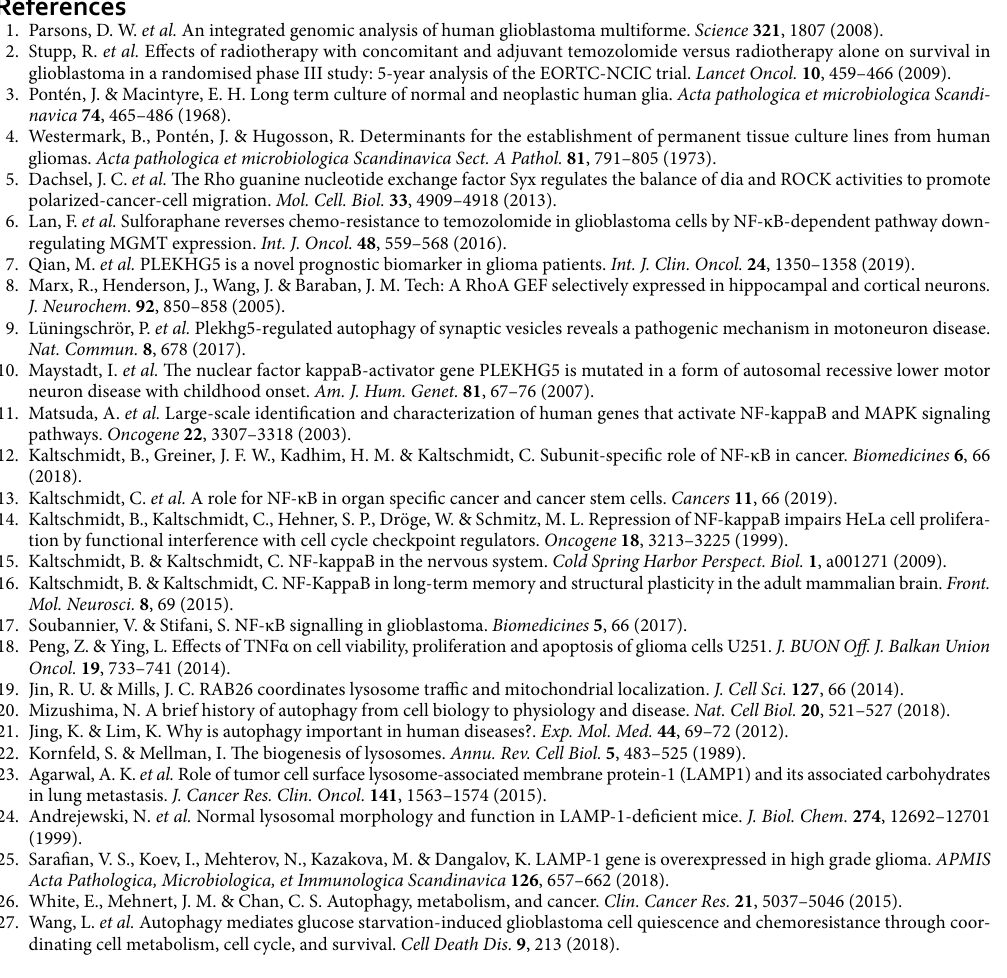
Figure 8. PLEKHG5 regulates NF-κB and MGMT in U251-MG. ( A ) Immunocytochemistry showed strong accumulations on MGMT expression after transduction with RAB26QL. Overexpression of RAB26 seemed to correlate with the amounts of MGMT protein, whereas PLEKHG5 rescue cells represented high levels of MGMT. ( B ) Survival analysis were performed by using Orangu Cell Proliferation Assay via measurement of photometric absorbance at 450 nm (upper row) and via determination of resulting cellular viability (lower row), after treatment with TMZ. Viability percentages of PLEKHG5 knockout and transduced U251-MG cells were examined compared to wildtype viabilities for each condition. PLEKHG5 +/+ cells showed significant decreases of OD’s/viabilities from control to treated cells. PLEKHG5-deficient cells depicted in all conditions very low levels of metabolic activity/cellular viabilities, compared to PLEKHG5 wildtype. Overexpression of RAB26 in PLEKHG5 −/− + RAB26QL cells recovered the sensitivity to TMZ, similarly to PLEKHG5 wildtype and rescued the cellular viability completely as compared to PLEKHG5 +/+ cells. PLEKHG5 +/+ + RAB26QL cells showed slightly lower levels of cellular viabilities but a similar trend as PLEKHG5 wildtype. Statistical analysis were performed with Mann–Whitney U tests (eight analysis for each condition and cell line), *** p ≤ 0.001, ** p ≤ 0.01 and * p ≤ 0.05 were considered significant. Mean ± SEM. ( C ) MGMT promoter methylation status of U251-MG and technical controls were analysed via bisulfide sequencing, depicting an average of 74.9 ± 5.3% methylated CpG-islands in PLEKHG5 wildtype, compared to PLEKHG5 knockout with 44.3 ± 4.8% of promoter methylation. Constitutive activity of RAB26QL in U251-MG cells displayed an intermediate phenotype with a promoter methylation average of 59.6 ± 4.0% ( PLEKHG5 rescue) and 72.9 ± 4.4% ( PLEKHG5 +/+ + RAB26QL). No statistical difference was examined between PLEKHG5 +/+ and PLEKHG5 +/+ + RAB26QL. One-way ANOVA with Bonferroni’s multiple comparison test, *** p ≤ 0.001 (grouped for each cell line and CpG-islands) was considered significant. Mean ± SEM. ( D ) Schematic representation of the analysed relation from PLEKHG5 to its downstream targets (black arrows). Next to regulating MGMT expression and cell morphology, PLEKHG5 was revealed to modulate cellular viability, which is directly associated with U251-MG cell survival. Grey arrow represents a previously published relation, which was not addressed in this